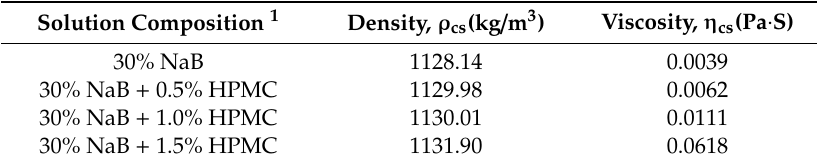
Table 1. Material properties of coating solution.